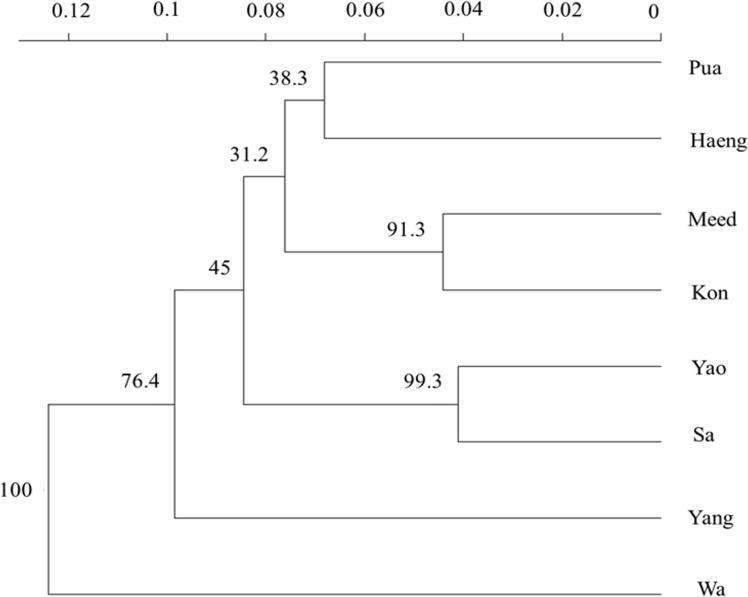
UPGMA dendrogram of eight population samples of Garra cambodgiensis based on Nei’s genetic distance (Nei, 1978) (indicated by a scale bar) with 1,000 bootstrap replicates at 11 microsatellite loci (bootstrap values are shown at nodes).